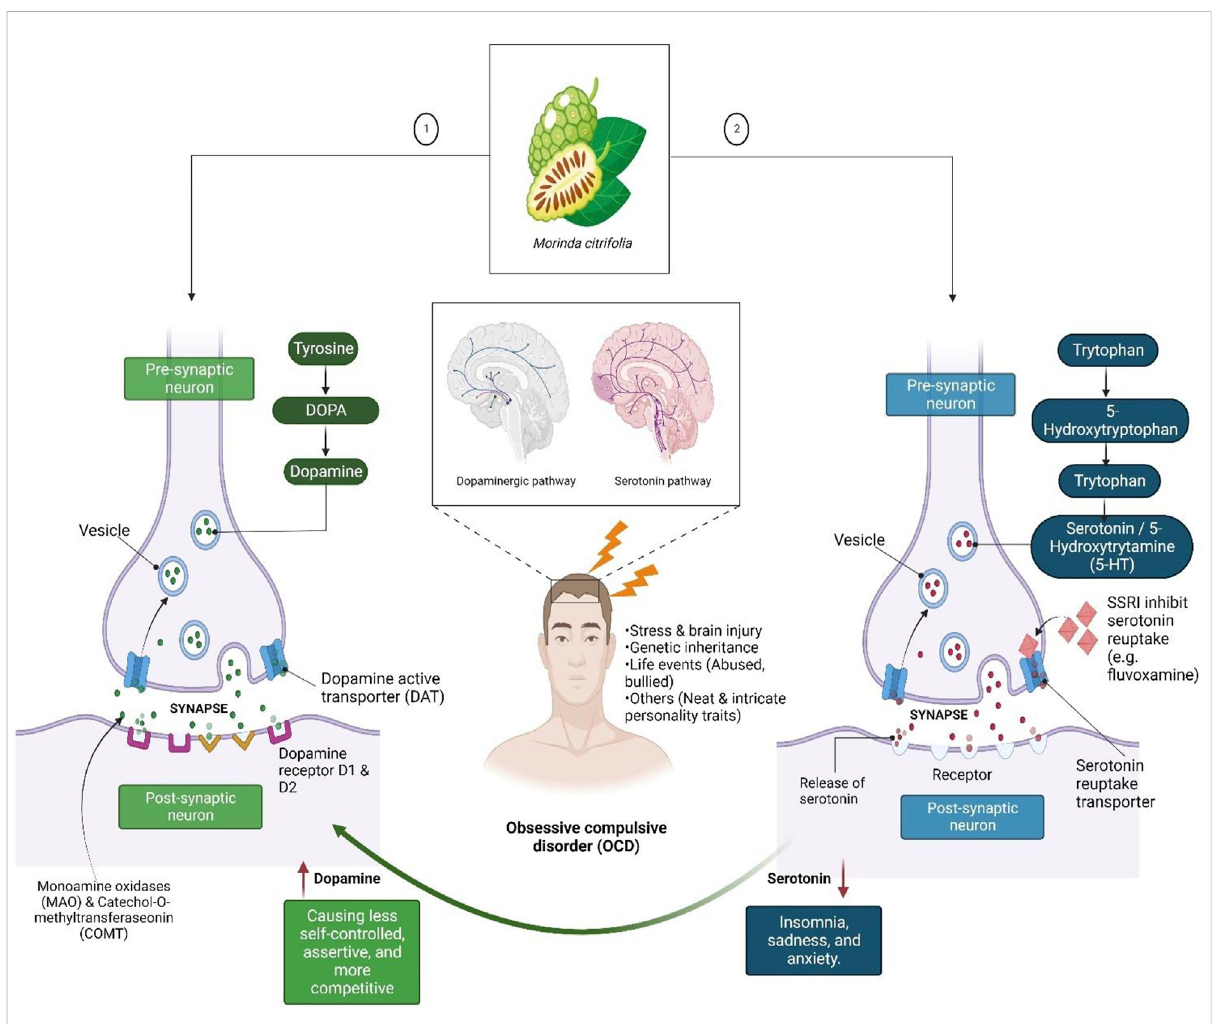
FIGURE 1 Dopamine (DA)and serotonin neurotransmitters,which are linked tofeelingsofhappiness,motivation, andrewards.DA bindswith theD1Rand D2R DA receptors after being released into the synaptic cleft by dopaminergic neurons to create excitatory or inhibitory transmission. A DA transportercanin fl uencetheamountofDApresent,whilecatechol-O-methyltransferaseandmonoaminemaydegradetheDAinthesynapticcleft. Low levels of DA may be linked to poor self-control and other productivity-related issues, whereas low levels of serotonin may cause mood crashes that result in insomnia, melancholy, and